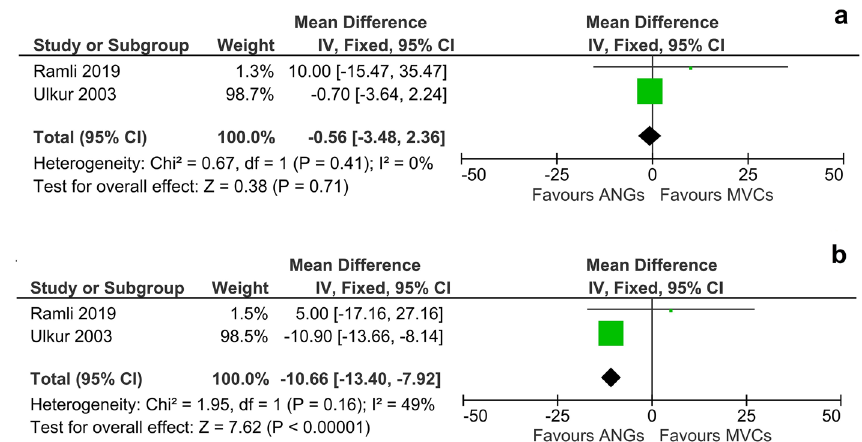
Figure 3. Meta-analysis of walking track performances (preclinical). Walking track performance at either 2 weeks ( a ) or 4 weeks ( b ) after sciatic nerve surgery was compared between rats who underwent nerve reconstruction either by means of an ANG or MVC. While the overall effect of the respective reconstruction method was not significant at WPO2, the meta-analysis revealed a significant effect (p < 0.01) in favor of ANGs at WPO4. While functional recovery was assessed by walking track analysis until WPO12 and WPO28, respectively, Ramli et al. excluded all animal of the MVC group starting from WPO6 due to severe autotomy of the affected limb. Therefore no meta-analysis of walking track analysis was performed at time points later than WPO4. Note that while no heterogeneity (I 2 = 0%) was detectable at WPO2, a moderate amount of heterogeneity (I 2 = 49%) was observable at WPO4.